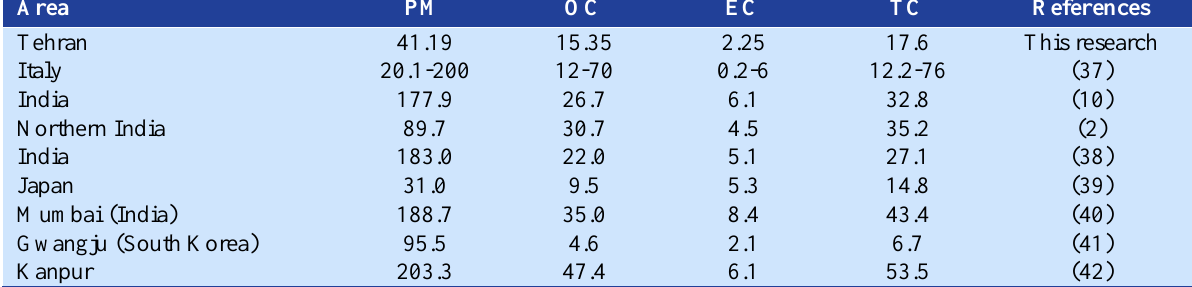
Table 3. Comparison of organic carbon (OC) and elemental carbon (EC) levels in PM from other areas Area PM